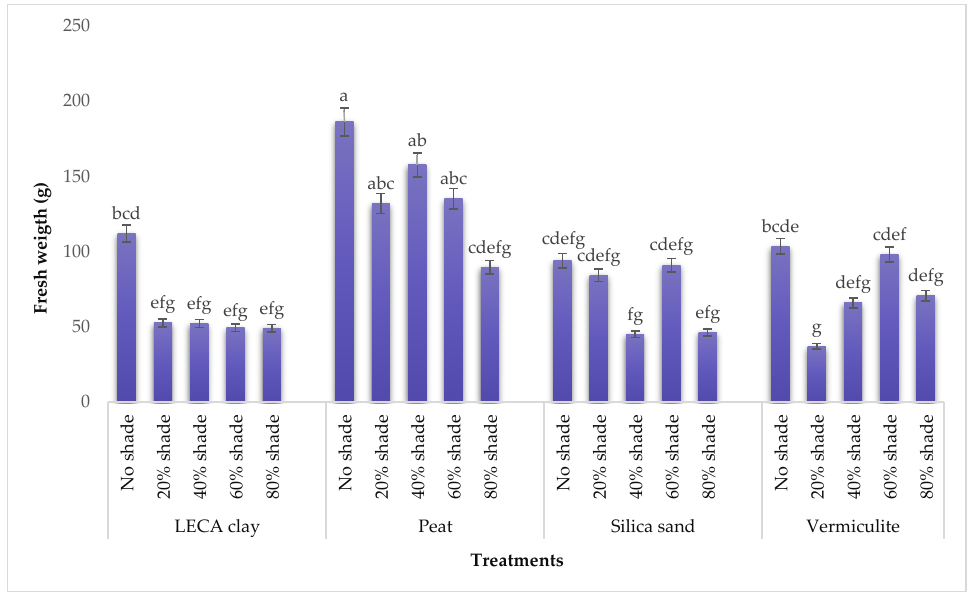
Figure 4. The effect of different growth media and different shade levels on the fresh weight of T. divaricata . Means at the same column followed by the same letter did not differ by Tukey ’ s test ( p > 0.05).